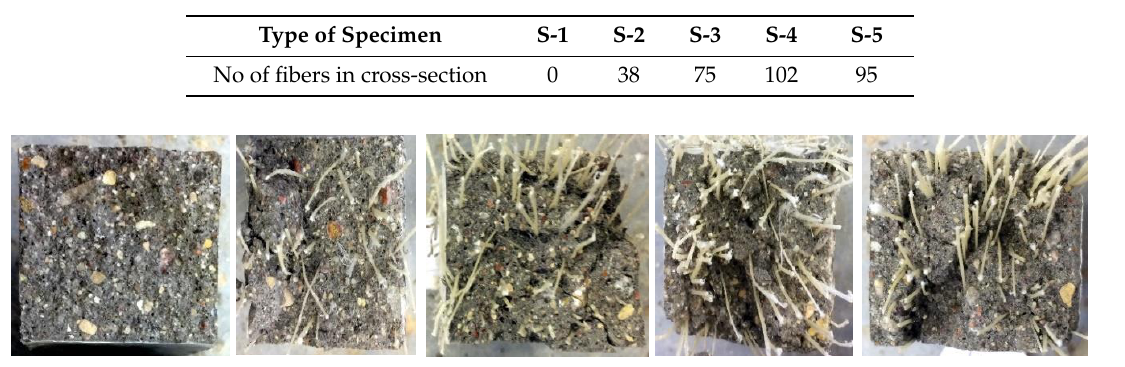
Figure 13. Cross section of concrete samples.